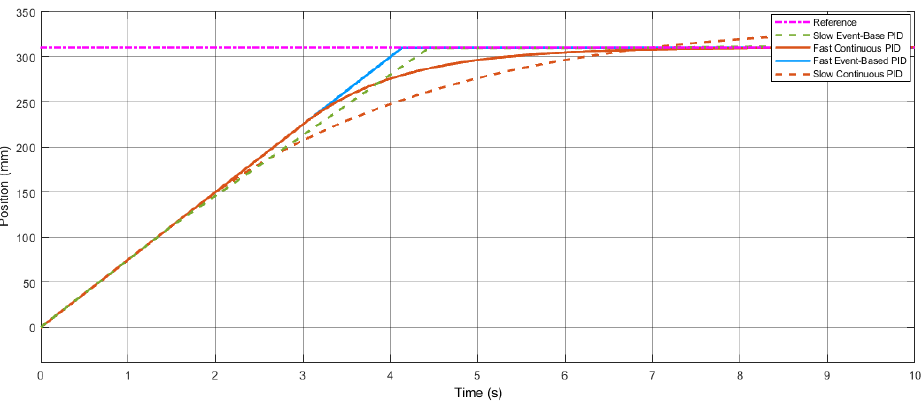
Figure 5. Event-based and continuous PID-measured responses in two different speed conditions.